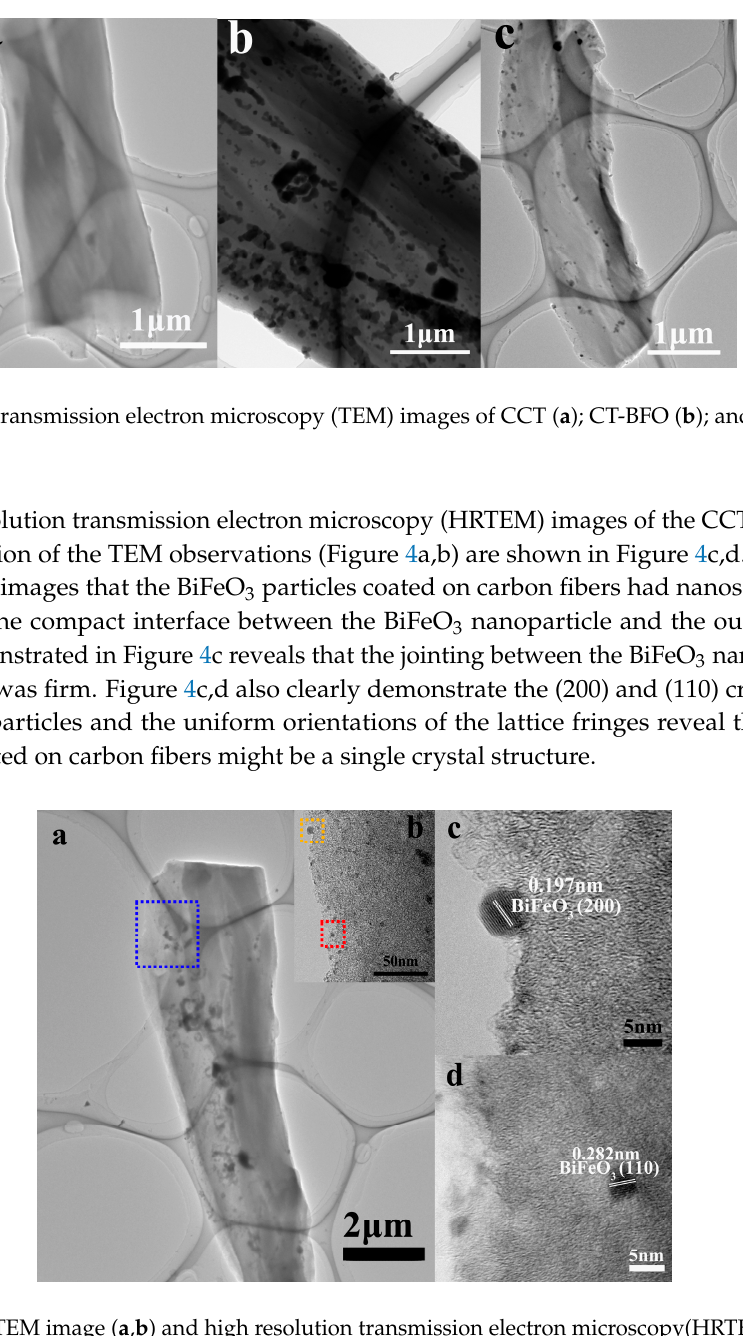
Figure 3. The transmission electron microscopy (TEM) images of CCT ( a ); CT-BFO ( b ); and CCT-BFO ( c ) respective.